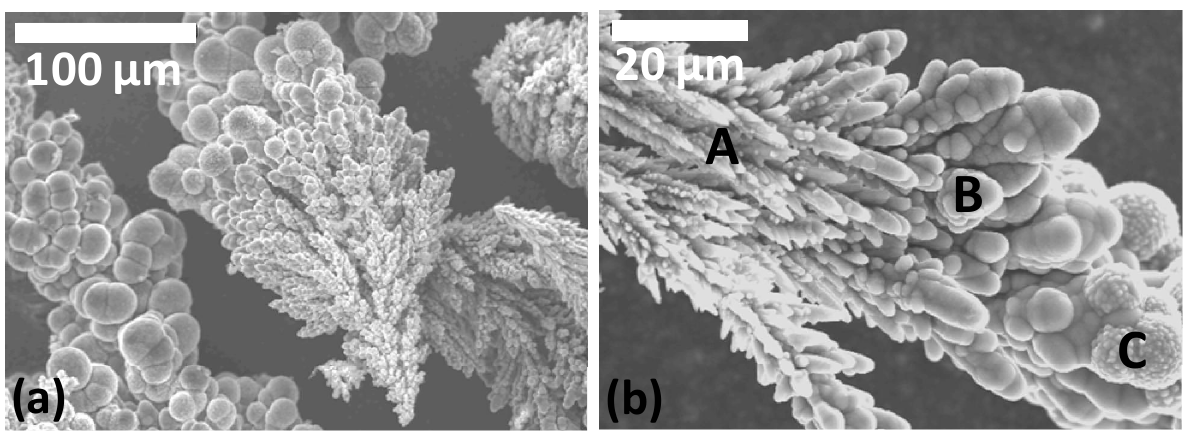
Figure 1. SEM image showing: ( a ) Al–Mg dendrites; ( b ) morphological evolution from feather-like (A) to smooth (B) and rough (C)